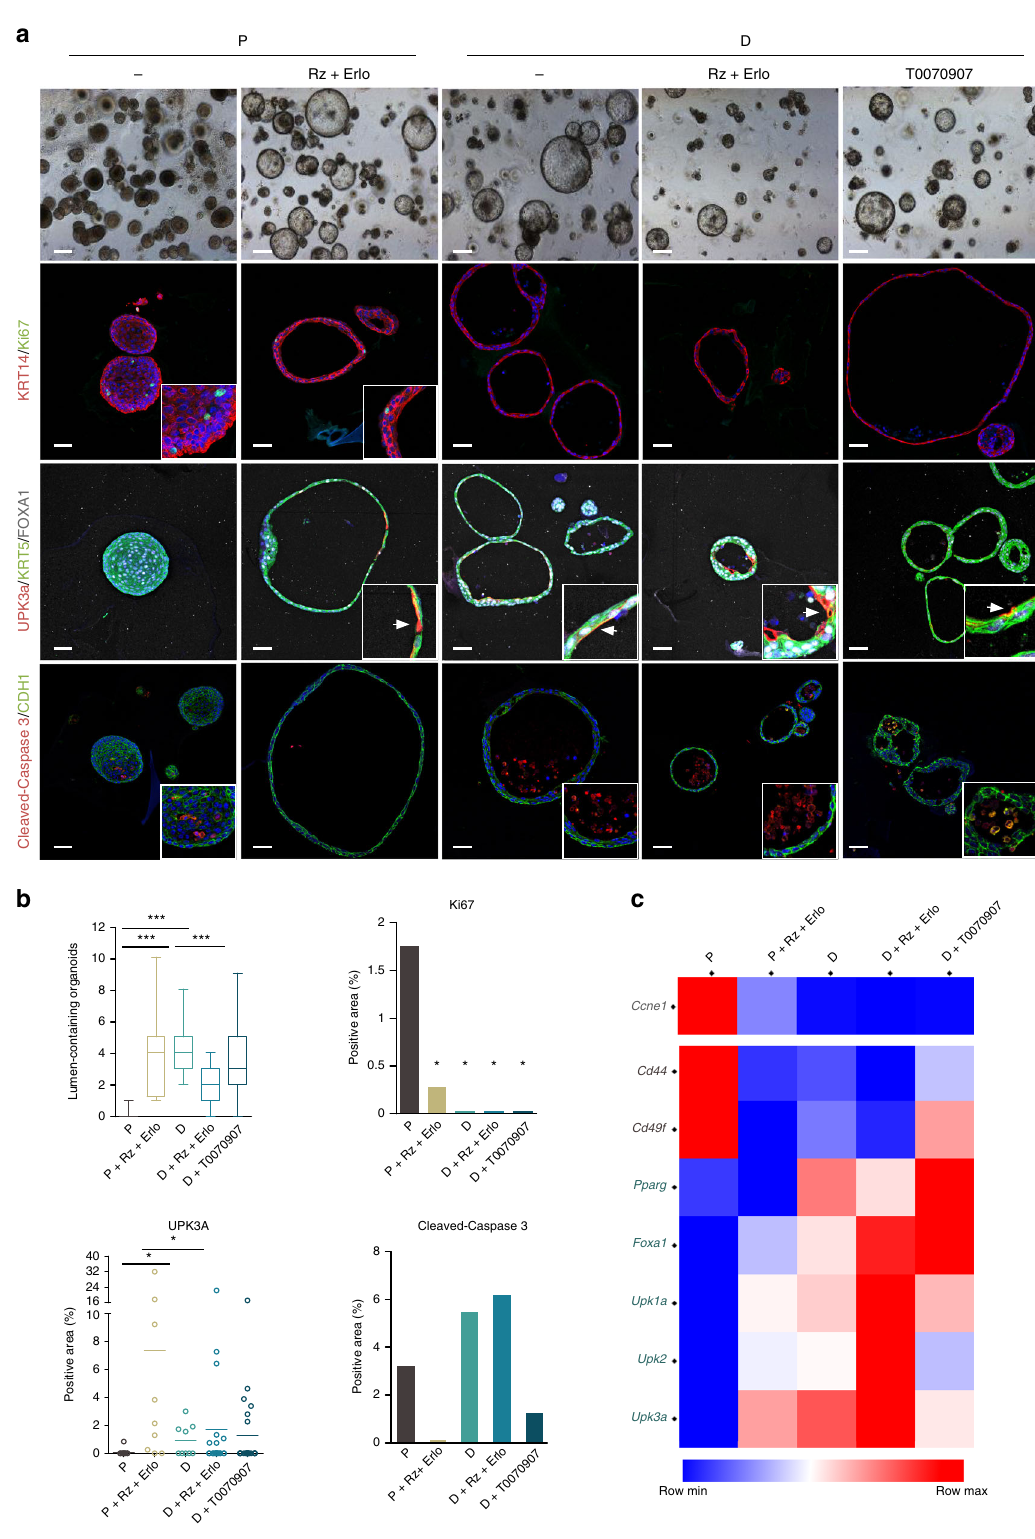
Fig. 4 Pharmacological modulation of EGFR and PPAR γ activity potentiates organoid differentiation. a Representative phase contrast and immuno fl uorescence images of proliferative (P) and differentiated (D) organoids cultured in the presence of drugs modulating PPAR γ (Roziglitazone, Rz) or EGFR activity (Erlotinib, Erlo) (scale bars: bright fi eld, 500 μ m; immuno fl uorescence, 250 μ m). b Quanti fi cation of lumen formation (Mann – Whitney test), Ki67, UPK3a, and cleaved-caspase-3 expression (Bonferroni test) in organoids cultured as described in panel a . c Heatmap representing RT – qPCR expression analysis of cell cycle and canonical urothelial differentiation markers in P or D organoids treated with Rz + Erlotinib, and with the PPAR γ inverse agonist T0070907 ( n = 2). * p ≤ 0.05, ** p ≤ 0.01; *** p ≤ 0.001. Source data are provided as a Source Data fi